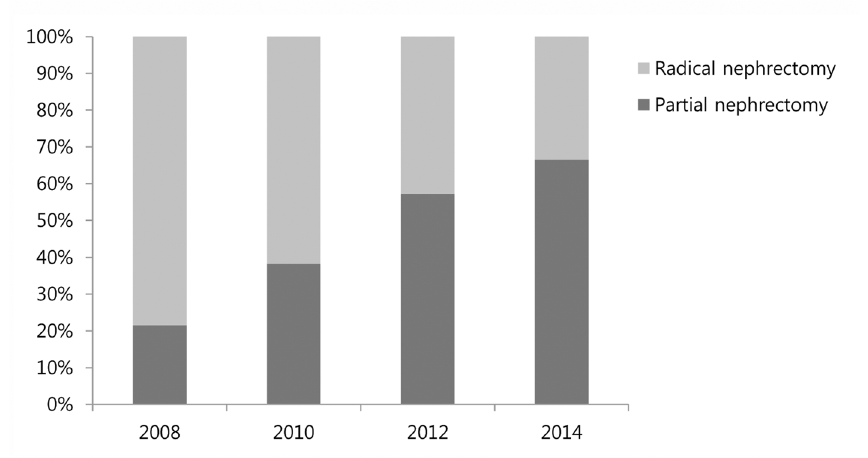
Fig 1. Proportion of patients treated by radical nephrectomy and partial nephrectomy by year.